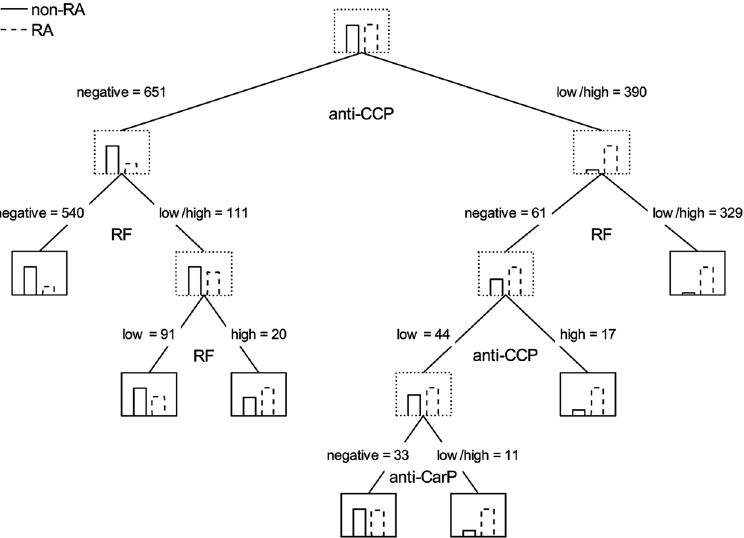
Figure 2. Smallest classification tree of the EA patients according with their antibody status in which the anti-CarP antibodies appear. This tree is not a valid classification tool, it is only an exploratory analysis of the role of anti-CarP antibodies. Each of the antibodies was considered as negative, low positive and high positive in an ordinal scale. The tree was allowed to grow until more than 15 RA and 15 non-RA patients remained to classify in any of the two groups, which was the smallest tree showing a split based on anti-CarP antibodies. Node lines are dotted, except for terminal nodes that show continuous lines. Nodes include histograms with the frequencies of the RA (discontinuous lined bar) and non-RA (continuous lined bar) patients at that level of the tree. The antibody used for each split is indicated under parent nodes. Over each child node appears the rule to reach it and the number of patients arriving to